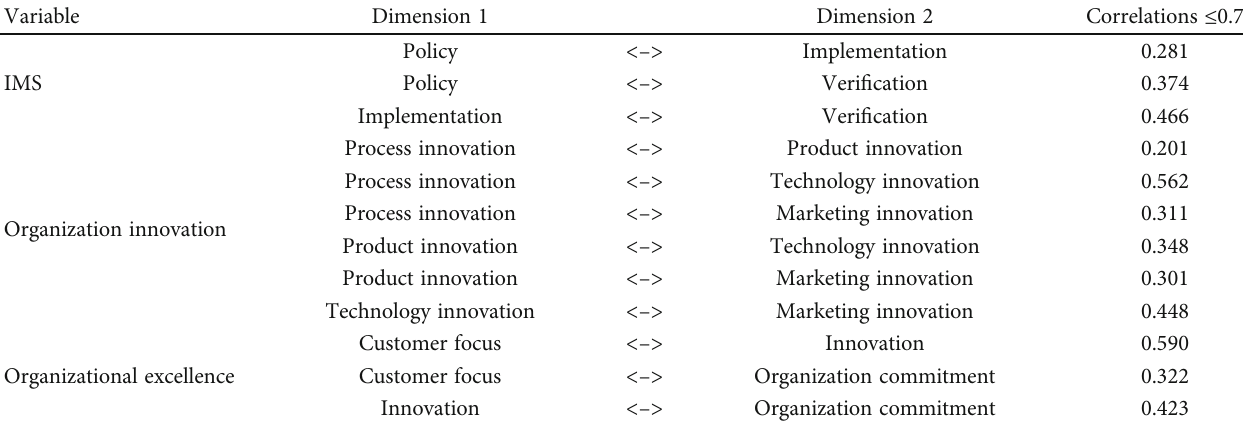
Table 8: Correlations between constructs.